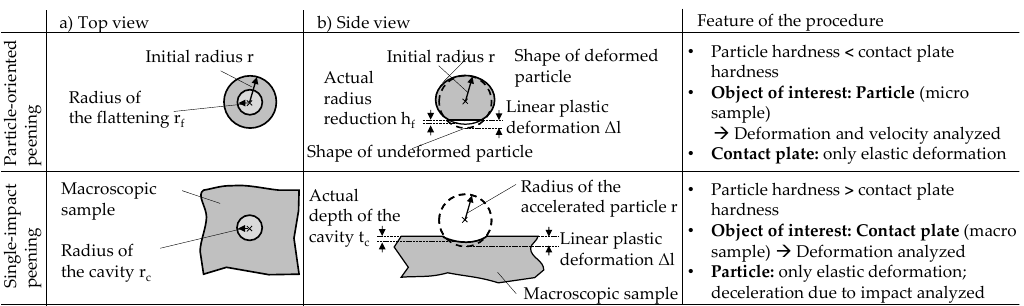
Figure 5. Definition of the determined descriptors (r f : radius of the flattening, r c : radius of the cavity, ∆ l: linear plastic deformation, t c : depth of cavity).